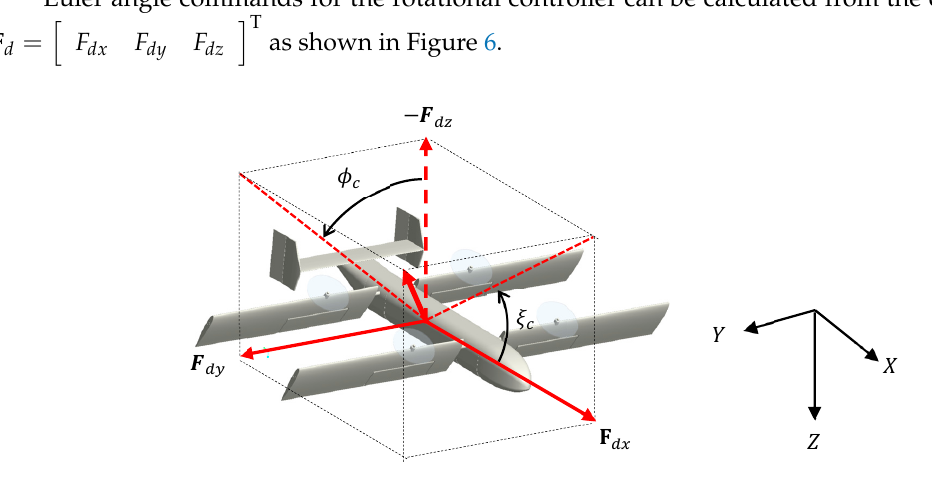
Figure 6. Definition of command angle.